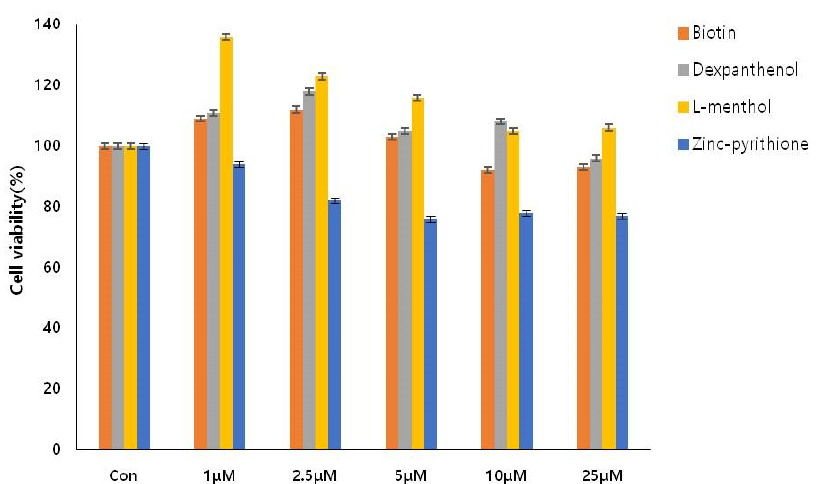
Figure 2. Effects of biotin, dexpanthenol, l-menthol, and zinc pyrithione on cell viability using Raw264.7 cells. The cells were treated with various concentrations (1–25 µ M) of biotin, dexpanthenol, l-menthol, and zinc pyrithione for 24 h, respectively. Cell survival was measured by MTT assay.